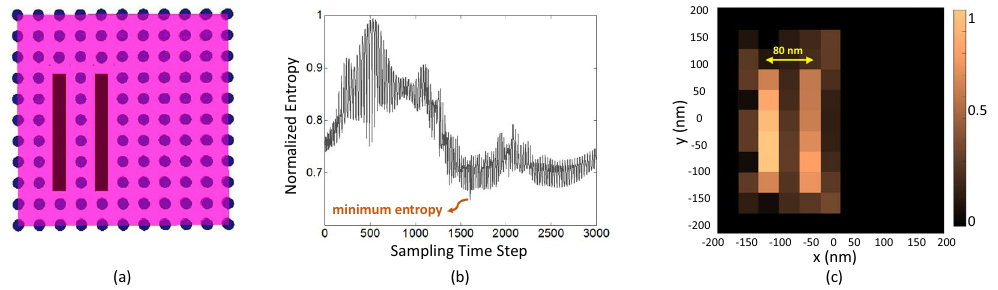
Figure 5. Imaging of two parallel bars inside tissue ( a ) input medium ( b ) minimum entropy concept to obtain the optimum time of imaging ( c ) reconstructed